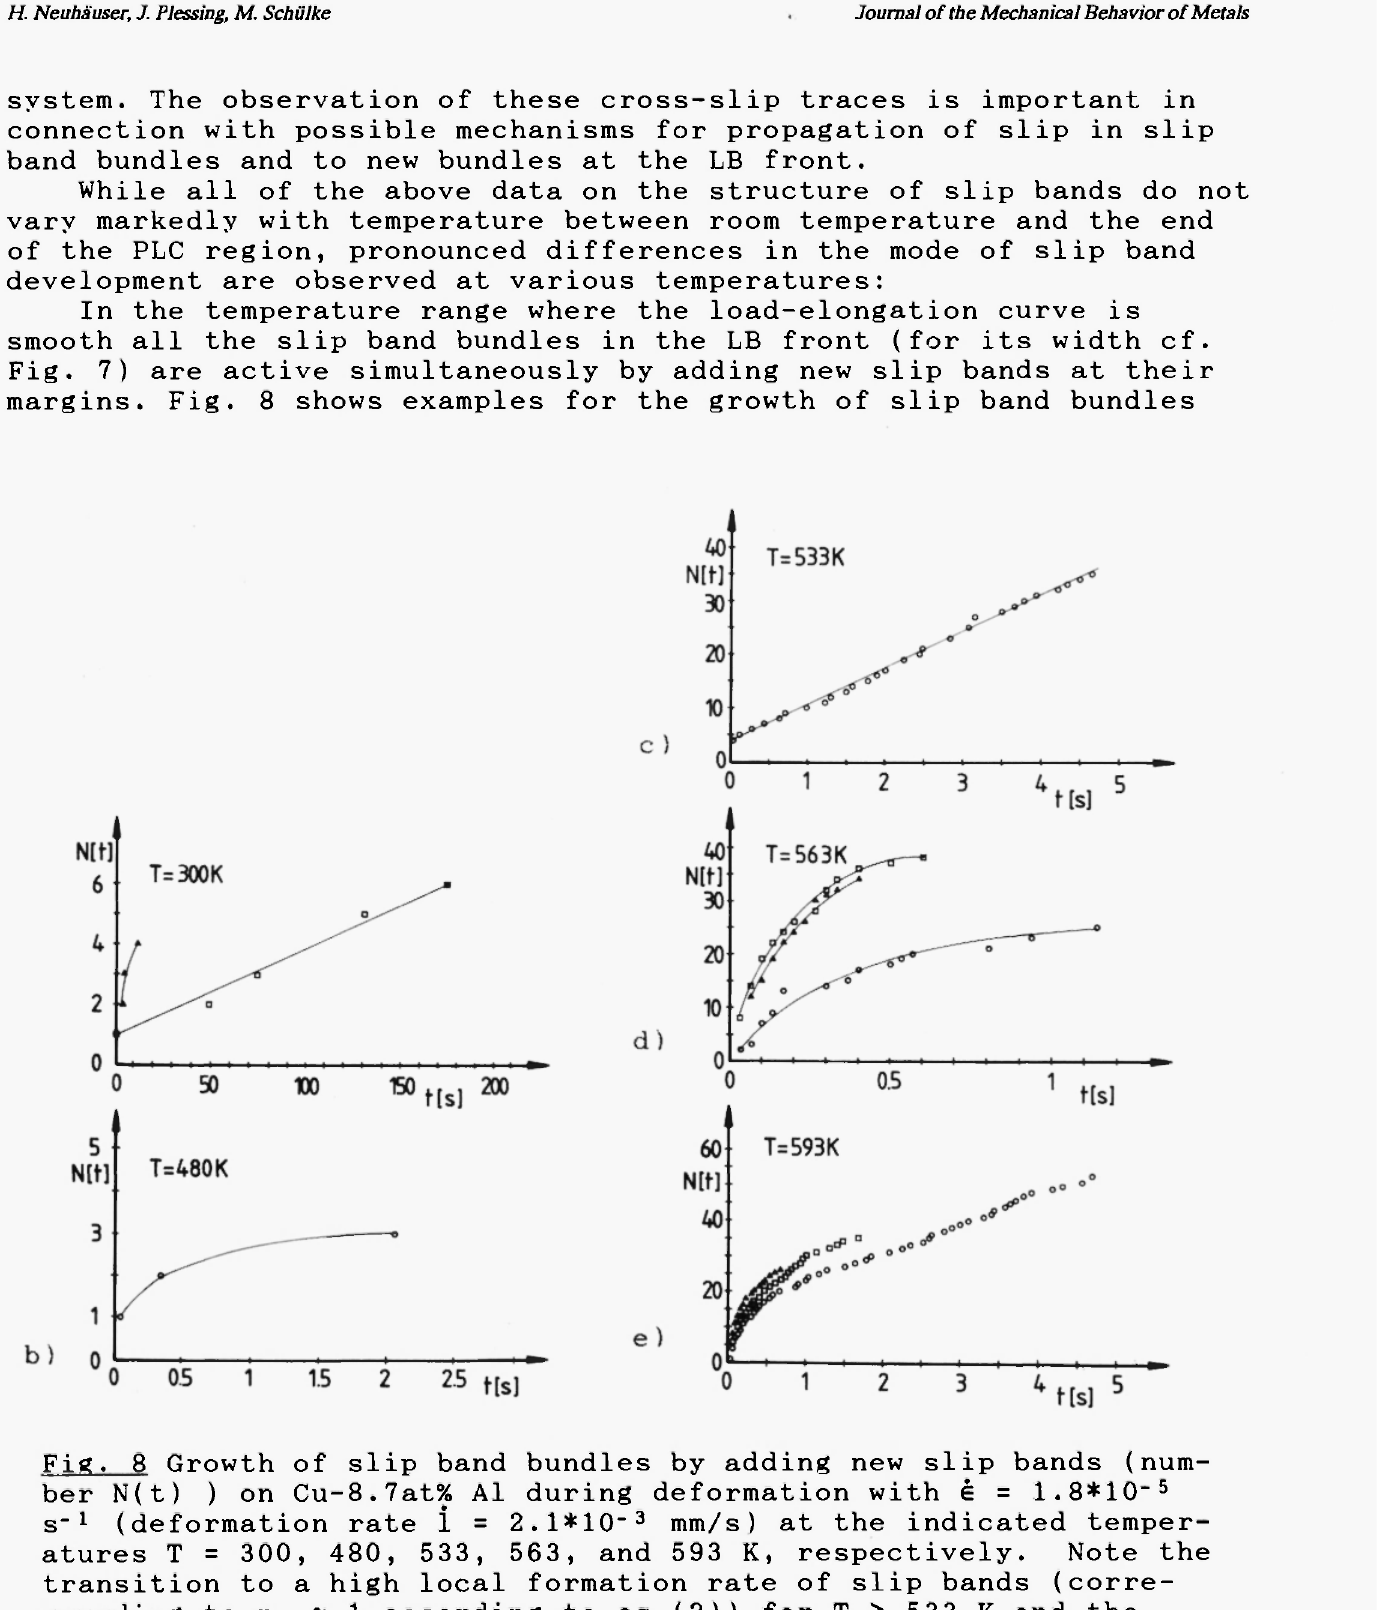
Fig. 8 Growth of slip band bundles by adding new slip bands (num- ber Ν(t) ) on Cu-8.7at% Al during deformation with έ = 1.8*10" 5 s" 1 (deformation rate ί = 2.1*10" 3 mm/s) at the indicated temper- atures Τ = 300, 480, 533, 563, and 593 K, respectively. Note the transition to a high local formation rate of slip bands (corre- sponding to n «1 according to eq.(2)) for Τ > 533 Κ and the a rapid initial formation rates during stress serrations for Τ > 563 Κ.